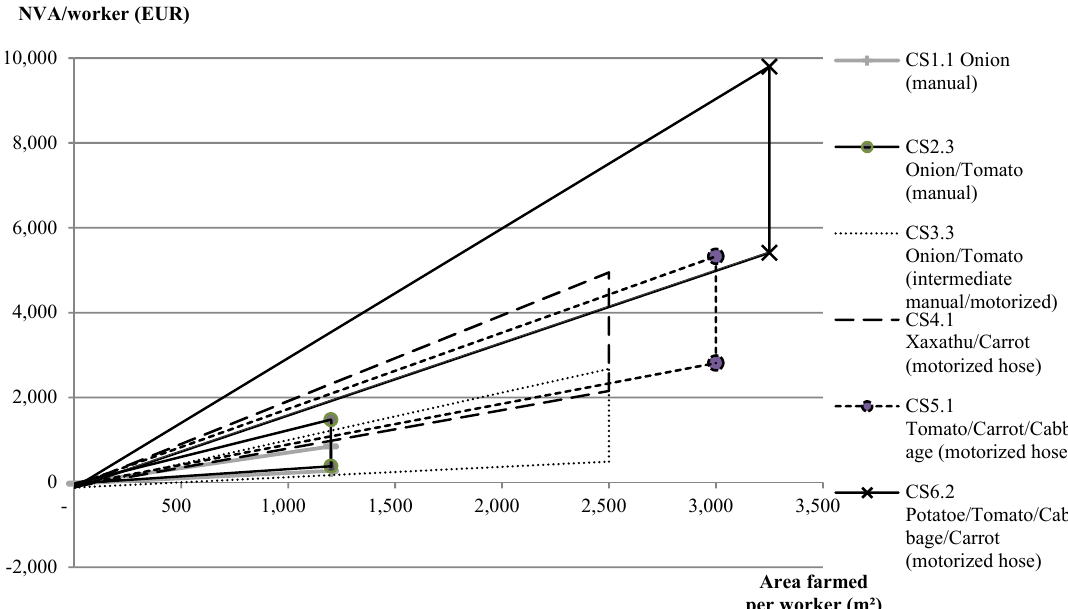
Figure 6. Comparative labour productivity of manual (CS1.1), semi-motorized (CS2.3), and motorized (CS 4.1, 5.1 and 6.1) cultivation systems. NVA: net value added; CS: cropping system.